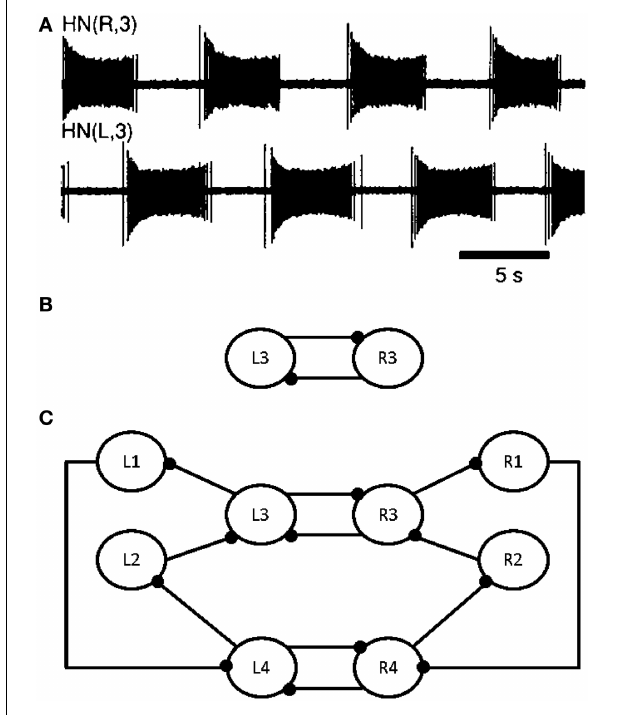
FIGURE 1 | Electrical activity of the leech heartbeat system and diagram of the CPG. Neuron cell bodies are represented by circles. Axons and neurite processes are represented by lines. Inhibitory chemical synapses are represented by small filled dots. (A) Electrical activity of two heart interneurons recorded extracellularly from a chain of ganglia (Hill et al., 2001). (B) A diagram of the elemental oscillator in the leech heartbeat system. (C) A diagram of the segmental oscillator in the leech heartbeat system, including two elemental oscillators, L3/R3 and L4/R4, and two pairs of coordination neurons, L1/R1 and